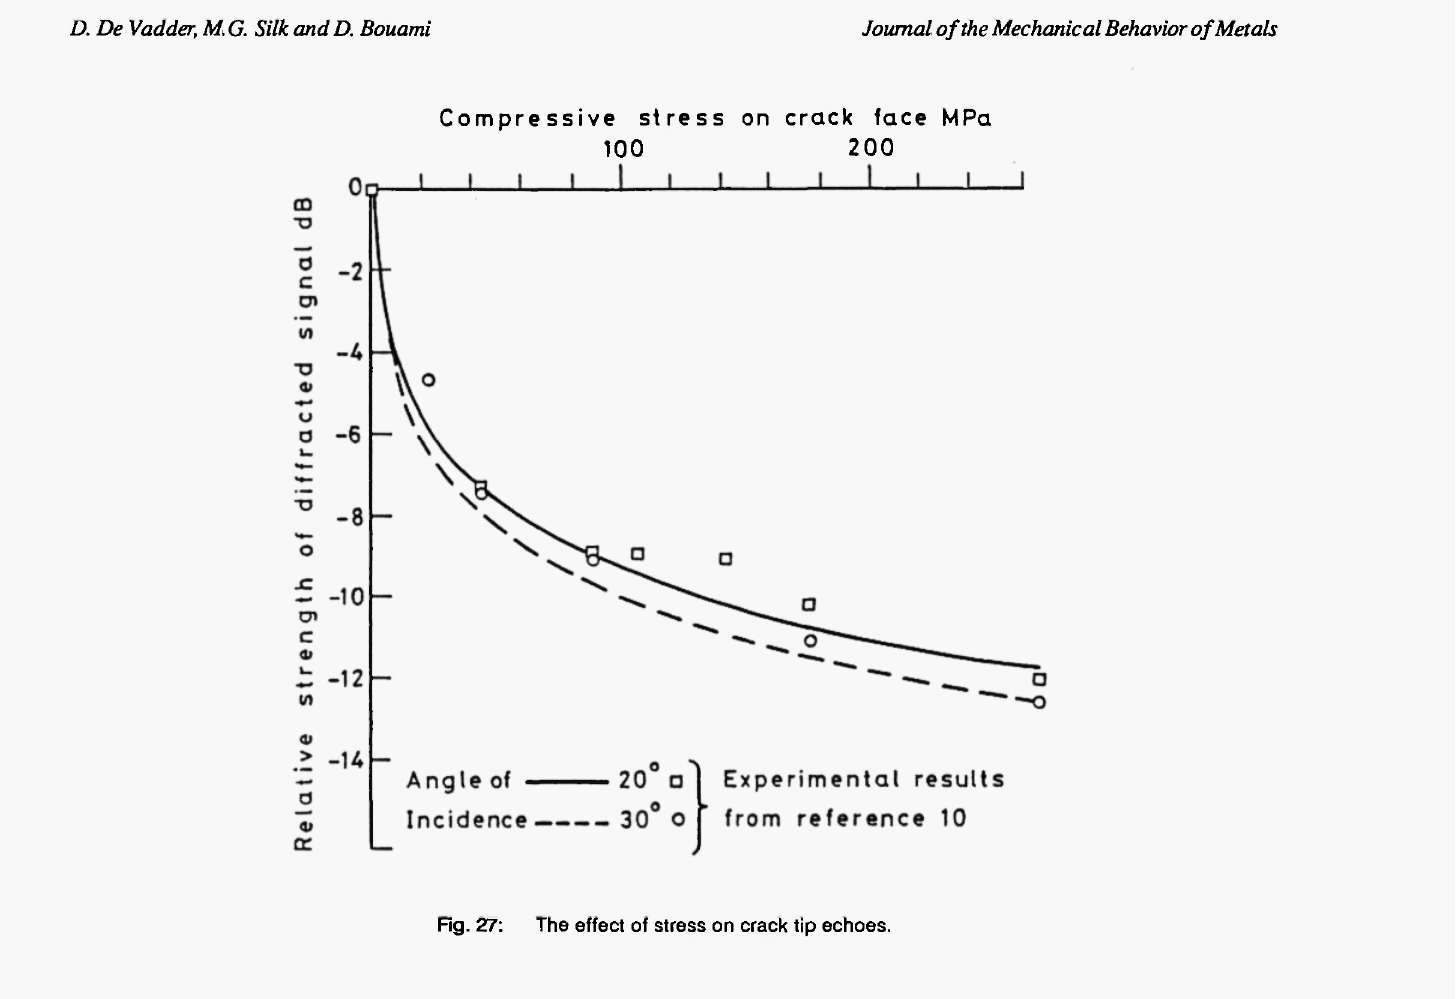
Fig. 27: The effect of stress on crack tip